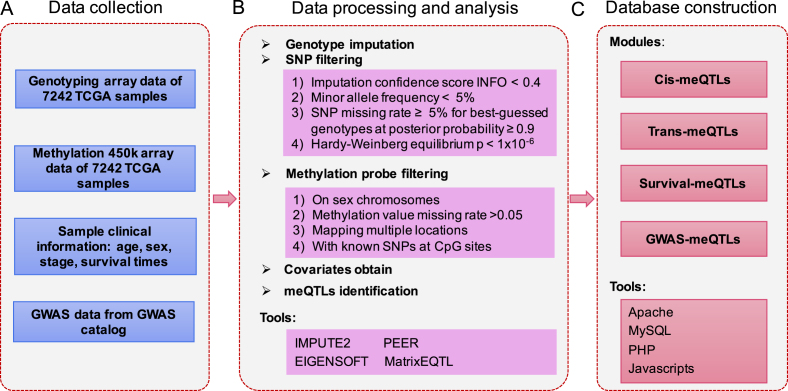
Data collection, processing and database construction. Pancan-meQTL collected the genotype, methylation and clinical data from TCGA to evaluate the effects of SNPs on methylation levels. For each cancer type, the data were processed using a series of filtering and quality control steps. Four datasets, cis-meQTLs, trans-meQTLs, survival-meQTLs and GWAS-meQTLs, are included in the database.